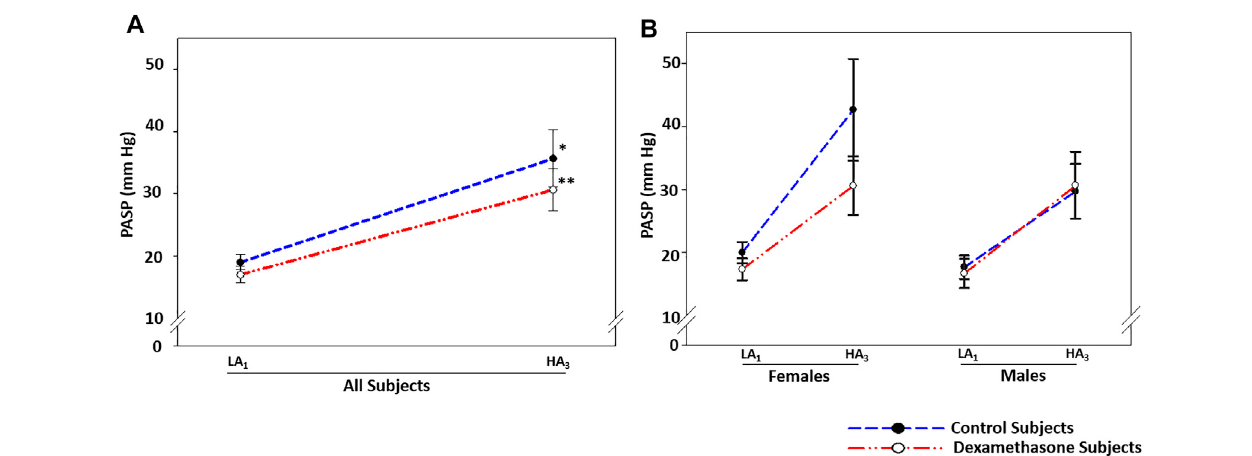
FIGURE 3 | Dexamethasone-mediated PASP-control at HA was predominant in women. (A) Dexamethasone attenuated the PASP elevation by ~3.1 mmHg. (B) Dexamethasone attenuated PASP by ~9.5 mmHg in women, while it could not control the rise in PASP in men. Data are presented as mean ± SE and are compared by one-way ANOVA. * p < 0.05, ** p < 0.01, and *** p < 0.001 were considered statistically signi fi cant. * represents signi fi cance within each group compared to respective control.